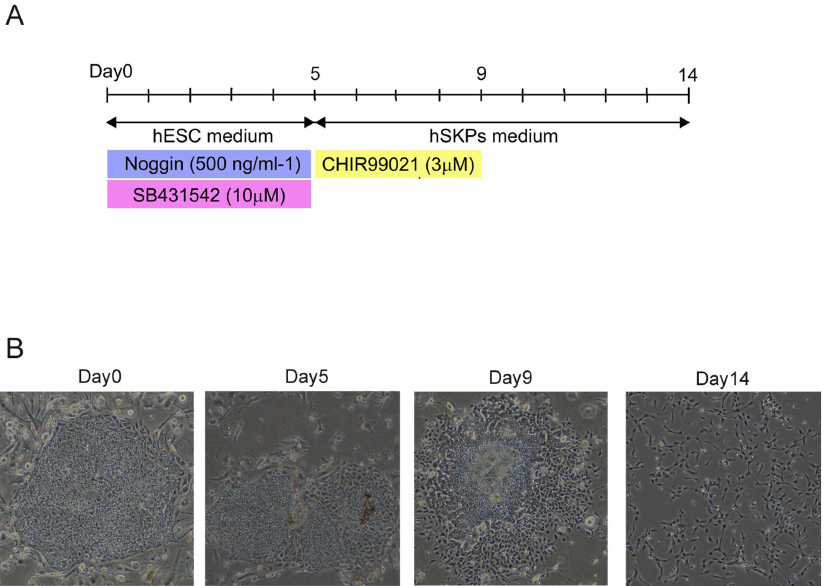
Fig 1. Generation of SKPs from hiPSCs. (A) Summary of the established protocolused to differentiate hiPSC-SKPs. Human iPSCs were culturedin initial differentiation medium with recombinantnogginand a TGF- β inhibitor (SB431542: SB). At day 5 of differentiation, the medium was changedto SKPs medium containing a WNT agonist(CHIR99021: CHIR) for 4 days. When the cells reached80% confluence, they were dissociated and subculturedin new dishes in SKPs medium without CHIR. (B) Morphologicalcharacteristics of hiPSCs